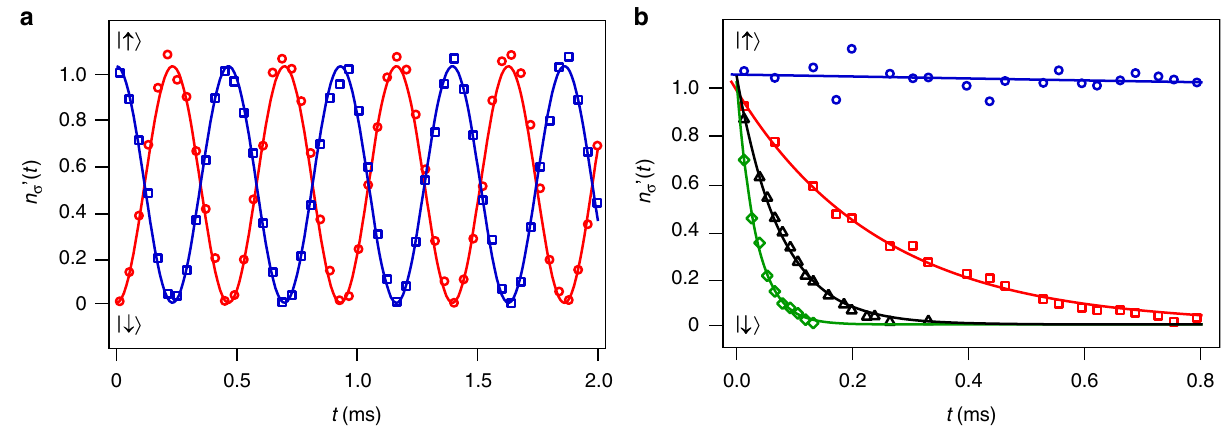
Fig. 4 Characterization of a dissipative Rabi system. Symbols are experimental data. Solid lines are theoretical fi ts. a In the presence of the RF fi eld but without the dissipative optical fi eld, atom numbers n ′ σ ð t Þ show Rabi oscillations with a Rabi frequency of 2 J = (2 π ) × 2.15 kHz. b In the presence of an optical fi eld resonant with | ↓ 〉 but without the RF fi eld, n ′ ð t Þ shows an exponential decay: Γ = 0.30 J (red squares), Γ = 0.98 J (black triangles), Γ = 2.35 J (green # diamonds). n ′ " ð t Þ remains almost constant during the experimental time. Blue circles show n ′ " ð t Þ when Γ = 0.30 fi nal trap depth of 2.2 μ K. In order to null the interaction between the two hyper fi ne states, the magnetic fi eld is fast swept to 527.3G, where the s-wave scattering length of the | ↑ 〉 and | ↓ 〉 states is zero 27 . The lifetime of the non- interacting Fermi gas is about 20 s, which is three orders of magnitude longer than our typical experimental time. So when the dissipative optical fi eld is absent, this noninteracting Fermi gas can be treated as a closed, two-level quantum system. To prepare a single component Fermi gas in the | ↑ 〉 state as the initial state, we apply a 5ms optical pulse with − 2 π × 30 MHz detuning from the | ↓ 〉 → 2 P 3/2 transition to blow away atoms in the | ↓ 〉 state. We typically have about N = 2.0× 10 5 atoms in a pure | ↑ 〉 state at temperature T ≈ 0.8 μ K and T / T F ≈ 0.5 with T F is the Fermi temperature. To generate Rabi oscillation between the two-spin states, we couple them via an RF fi eld with frequency ω and coupling strength J . An optical beam resonant with the | ↓ 〉 → 2 P 3/2 transition is used to create the number dissipation (atom loss) in the | ↓ 〉 state. The resonant-photon recoil energy of 3.5 μ K is ~50% larger than the trap depth, so the atom that absorb a photon will leave the trap quickly, resulting a state-dependent atom loss. The RF coupling strength J is measured in the absence of the dissipative optical fi eld, while the atom-number loss rate 2 Γ is measured in the absence of the RF coupling. Figure 4a shows the Rabi oscillation with Rabi frequency 2 J . Figure 4b shows the atom numbers n ′ # ð t Þ ¼ n ′ # ð 0 Þ exp ð(cid:2) 2 Γ t Þ with a constant dissipative optical fi eld that only couples the | ↓ 〉 state to the continuum. These measurements are used to calibrate the values of J and Γ for the dissipative two-state Rabi system.